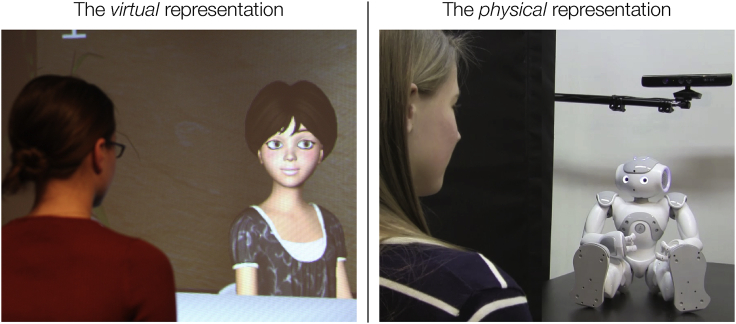
Experimenters demonstrating interaction with the representations used in the case studyThe virtual character Andrist et al. (2013) on the left and the social robot on the right Andrist et al. (2014). Copyright information: left: Springer; right: Bilge Mutlu.